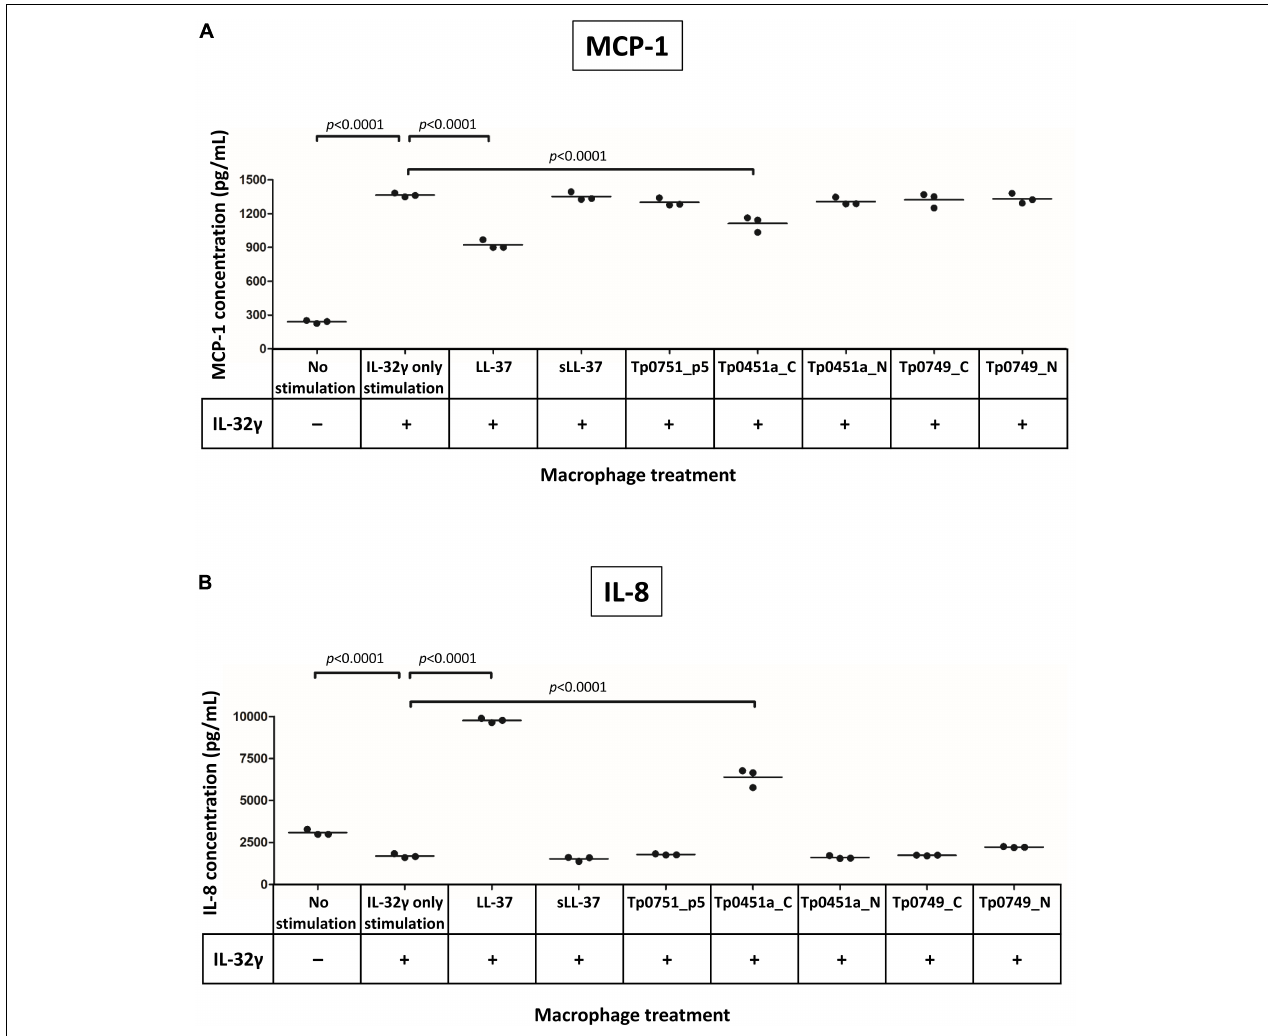
FIGURE 7 | Analysis of the immunomodulatory capacities of the T. pallidum AMPCCRs. Human THP-1 cells were differentiated to macrophages and then stimulated with or without IL-32 γ . Cells were then immediately exposed to either LL-37, sLL-37, Tp0751_p5, Tp0451a_C, Tp0451a_N, Tp0749_C, or Tp0749_N and analyzed for expression of (A) MCP-1 and (B) IL-8. Each data point is representative of cells from one well of a 12-well plate. Data shown is representative of three independent experiments. A Dunnett’s multiple comparisons test was used for normally distributed data and a Dunn’s multiple comparisons test was used for data that was not normally distributed. For statistical analyses, mean values from each peptide were compared to the mean of the unstimulated control (IL-32 γ only stimulation); p -values (Dunnett’s multiple comparisons test) indicating statistically significant differences observed in three independent experiments are